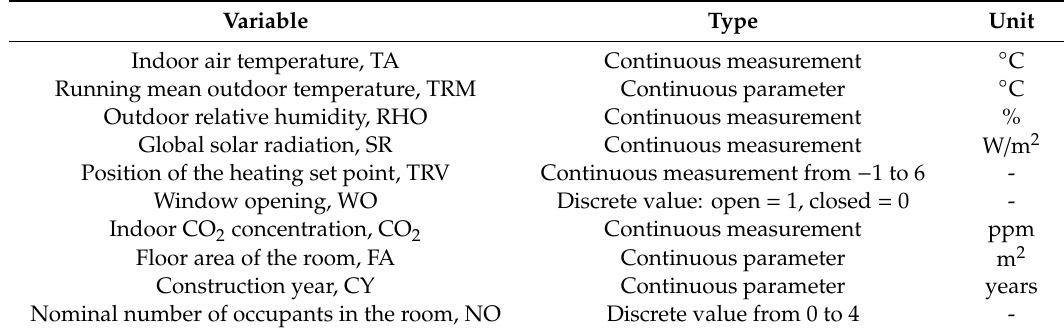
Table 2. List of attributes used to train air temperature (TA)-prediction